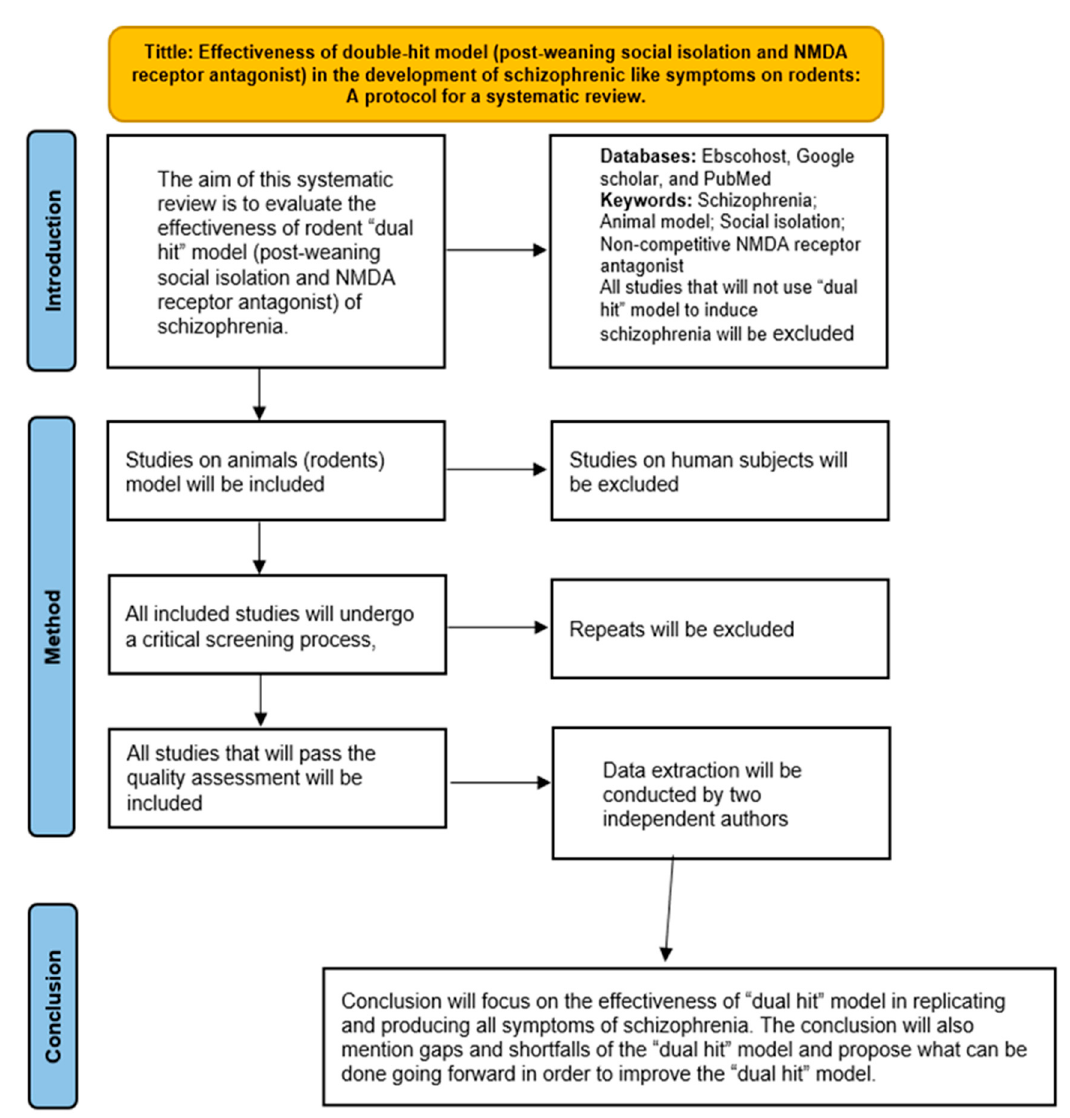
Figure 1. Flow diagram showing the summary of the protocol.